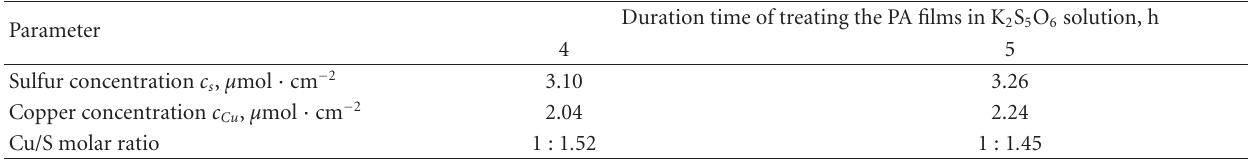
Table 1: Chemical composition of Cu x S layers formed in PA matrices, depending on the duration of film pretreatment time.